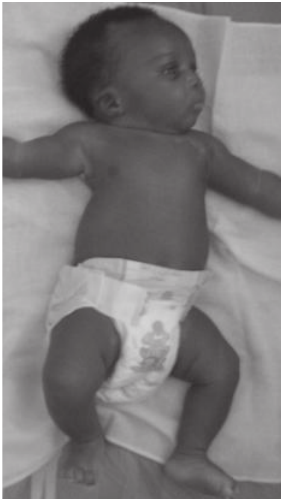
Figure 1: Clinical aspect showing the right-sided basithoracic exca- vation with the result of an asymmetrical chest-wall deformity.